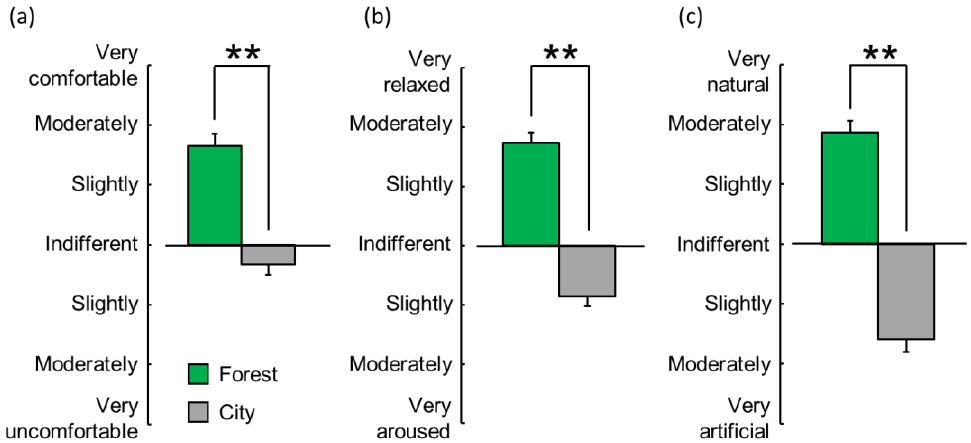
Figure 6. Subjective feelings on three scales (comfortable–uncomfortable ( a ), relaxed–aroused ( b ), and natural–artificial ( c )), as measured by a modified semantic differential method, after exposure to the forest vs. city sounds. Data are expressed as mean ± standard error (n = 29). ** p < 0.01 determined by the Wilcoxon signed-rank test (one sided).